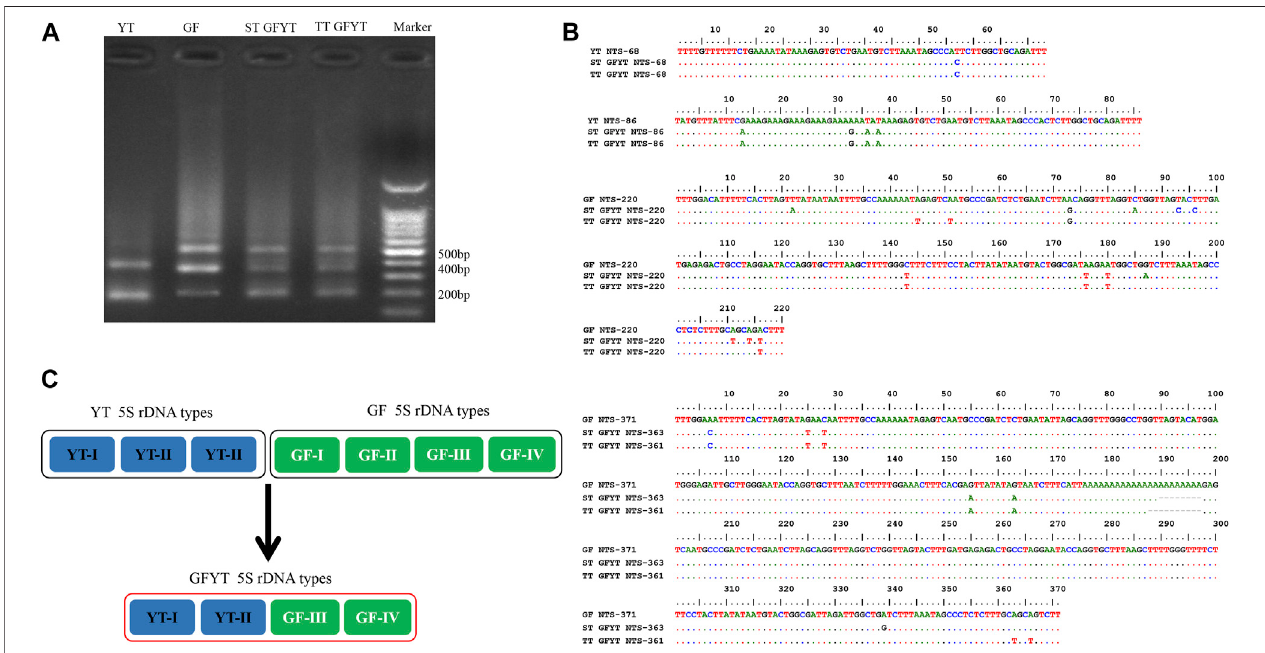
FIGURE 3 | Hereditary characteristics of 5S rDNA units in GFYT hybrids and their parents. (A) DNA bands ampli fi ed from GF, YT, and GFYT hybrids. Marker: DNA ladder markers with 100 bp increments. (B) Alignment of the NTS sequences. (C) Ideogram presenting the genetic constitution of 5S rDNA units in GFYT hybrids.